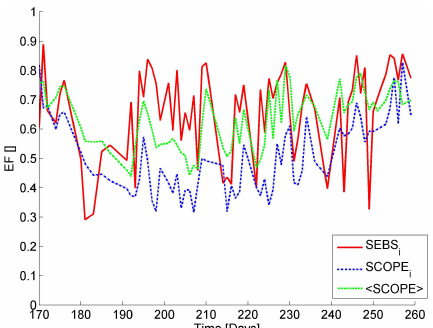
Fig. 8. Variation in evaporative fraction during the maize growing season. Evaporative fractions at overpass time calculated by SEBS and SCOPE are shown, as well as the daily average values of the evaporative fraction by